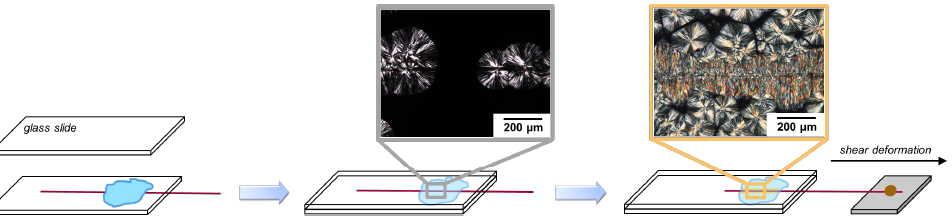
Figure 1. Sample preparation procedure for thin polymer films containing a single fiber. By control- ling the fiber velocity and temperature history, a well-defined cylindrical microstructure was